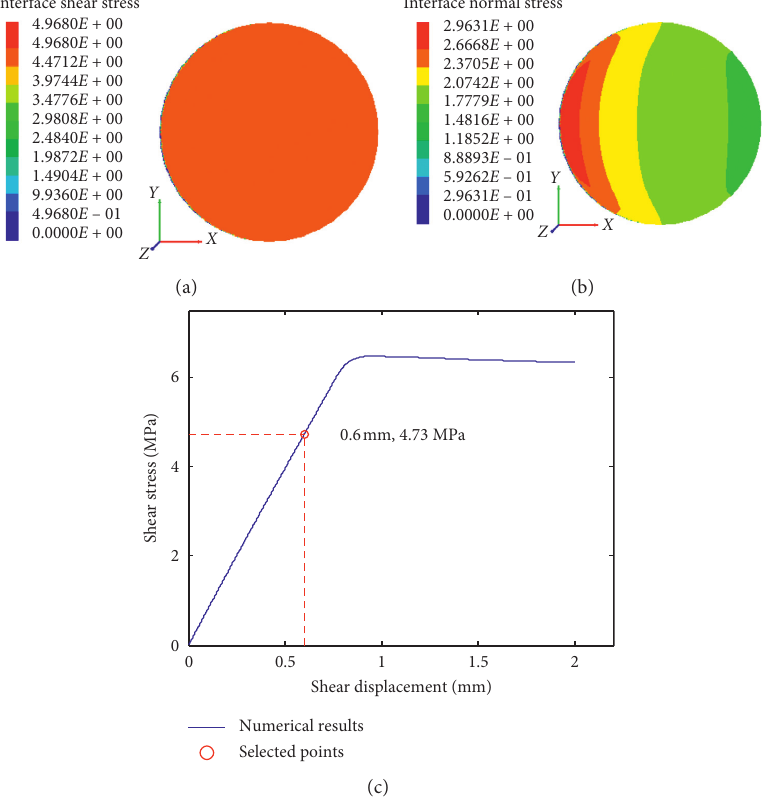
Figure 13: Distribution of the shear stress and normal stress on the shear failure plane when the shear displacement arrived at 0.6 mm: (a) shear stress distribution; (b) normal stress distribution; (c) point selected on shear stress-shear displacement curve. Interface shear stress 7.3267 E + 00